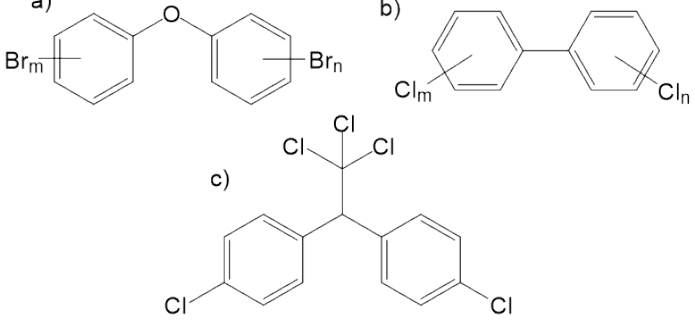
Figure 1. General structure of ( a ) polybrominated diphenyl ethers (PBDEs), ( b ) polychlorinated biphenyls (PCBs), and ( c ) dichlorodiphenyltrichloroethane (DDT).